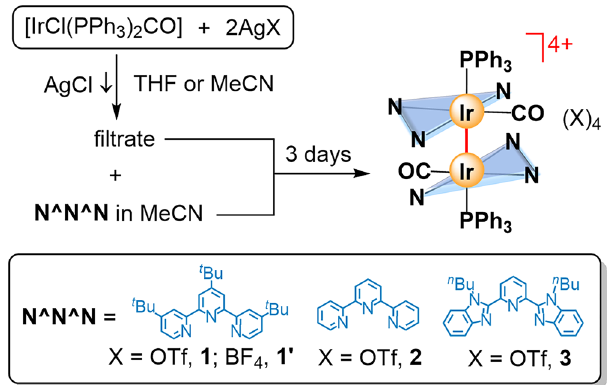
Fig. 2 Synthetic route of tetracationic diiridium(II) complexes with an unsupported Ir – Ir bond tetracationic diiridium(II) complexes. Synthesis of